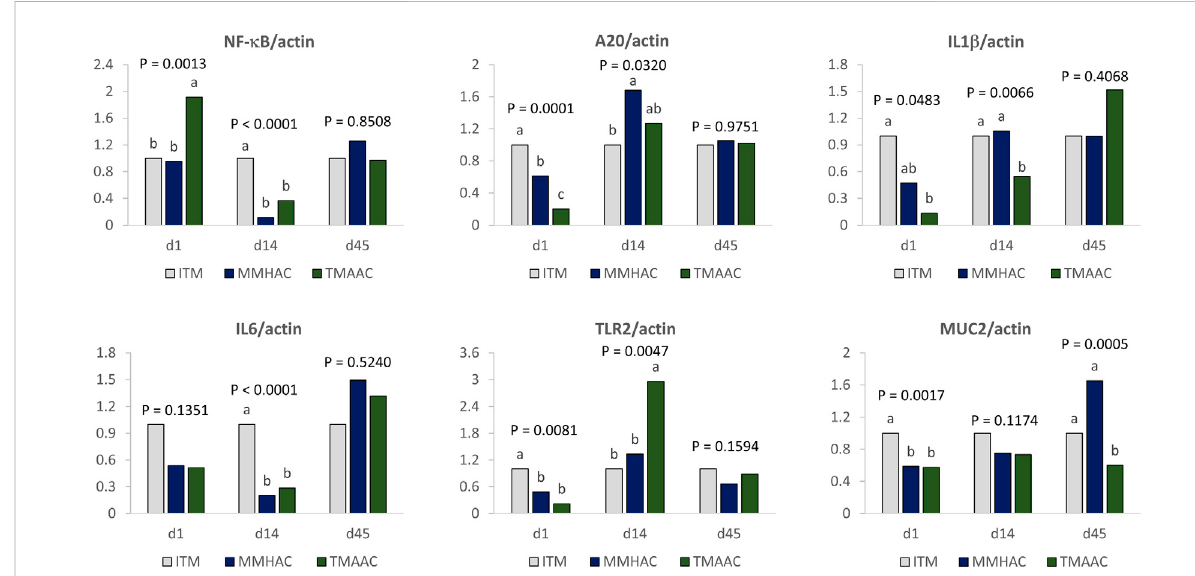
FIGURE 2 Effect of inorganic or organic trace minerals on jejunal anti-in fl ammatory gene expression in progeny broilers at 1-, 14-, and 45-days of age. ab Means without a common superscript differ ( p ≤ 0.05). ITM — inorganic trace minerals: 100, 16, and 100 ppm of Zn, Cu and Mn respectively,